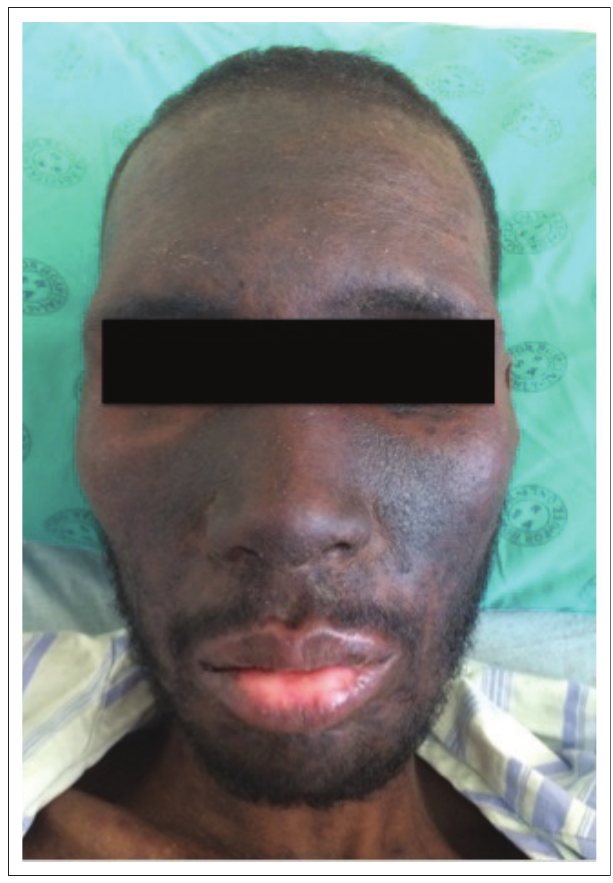
FIGURE 3: Chronic actinic dermatitis.